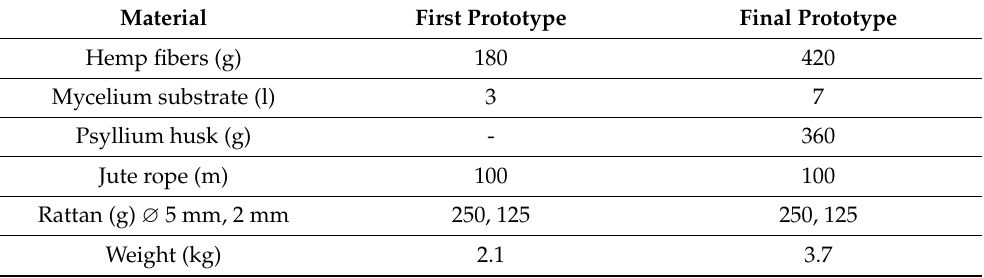
Figure 10. Section: 1. Rattan ∅ 2 mm, 2. Rattan ∅ 5 mm, 3. Mycelium substrate, 4. Hemp fibers. Table 1. Material overview.